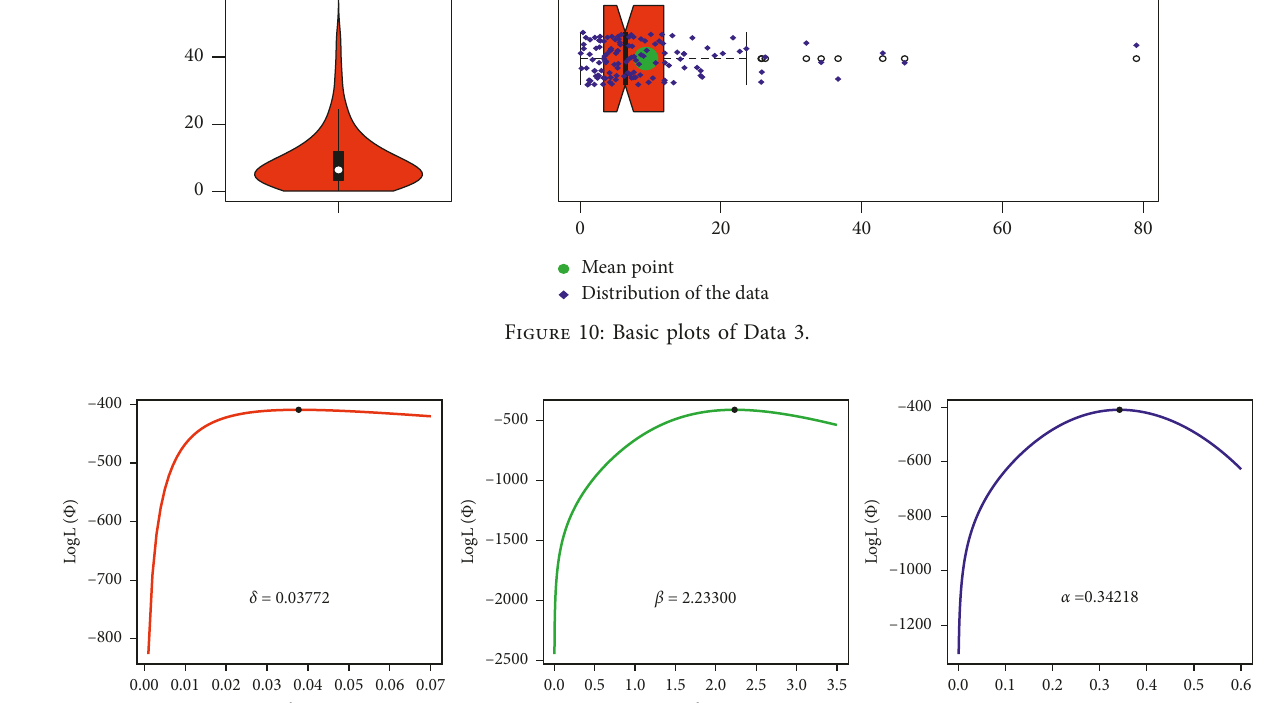
Table 10: The values of 􏽢 α